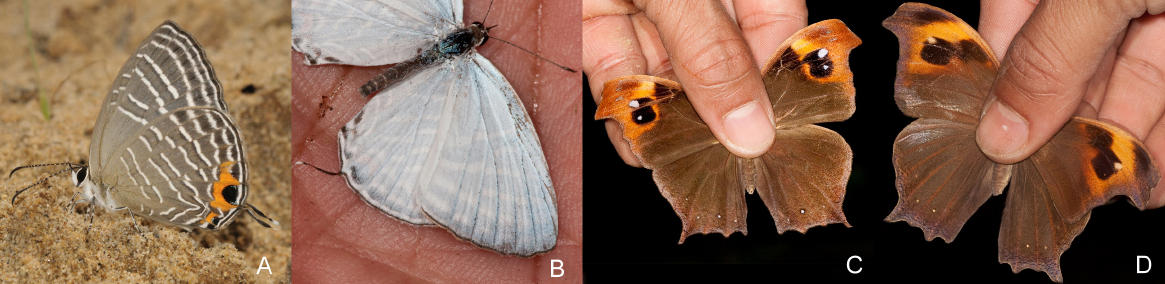
Image 2. Images of wild and wild-caught butterflies to illustrate key distinguishing features of Jamides pura , Melanitis phedima and M. zitenius specimens photographed in the Garo Hills and used in both our paper and the book. Image copyright: A: Sanjay Sondhi, B-D: Krushnamegh